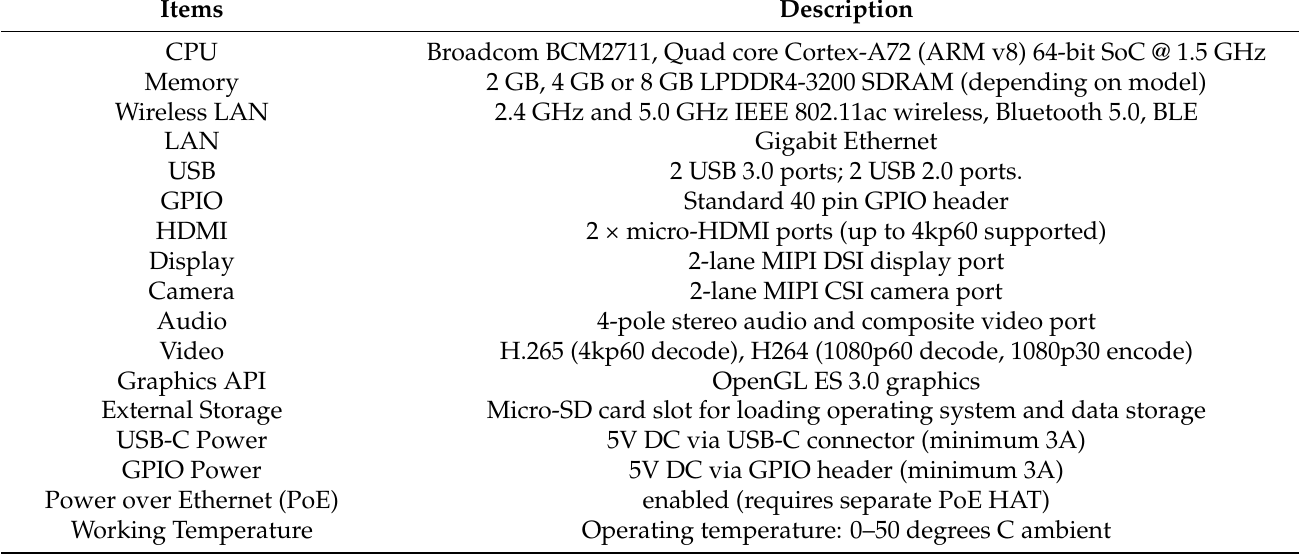
Table 2. Specifications of Raspberry Pi